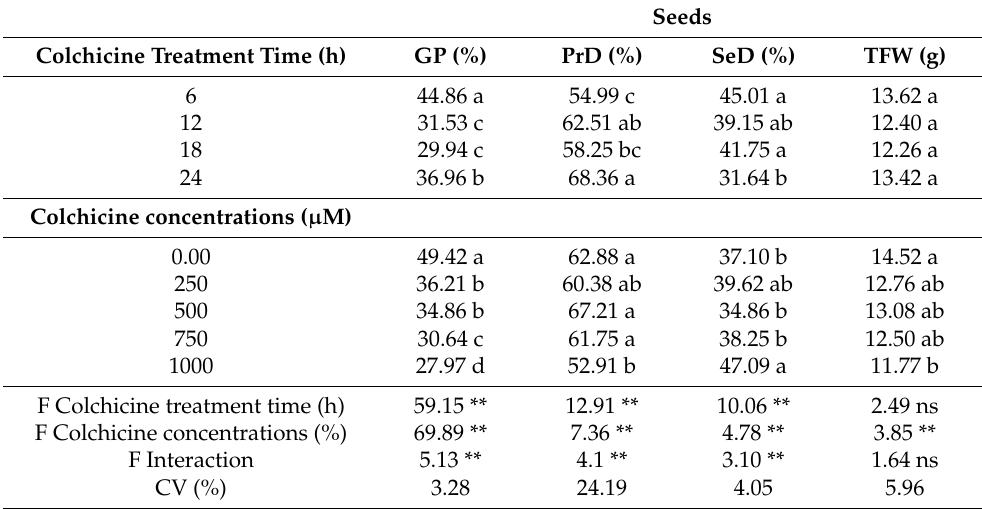
Table 1. Germination percentage (GP), percentages of seeds developed into protocorms (PrD) and into seedlings (SeD) and total fresh weight (TFW) of Blc. Haw Yuan Beauty x Blc. Goldenzelle “LC” seed progeny exposed to different times and concentrations of colchicine. Seeds Colchicine Treatment Time (h) GP (%) PrD (%) SeD (%) TFW (g)